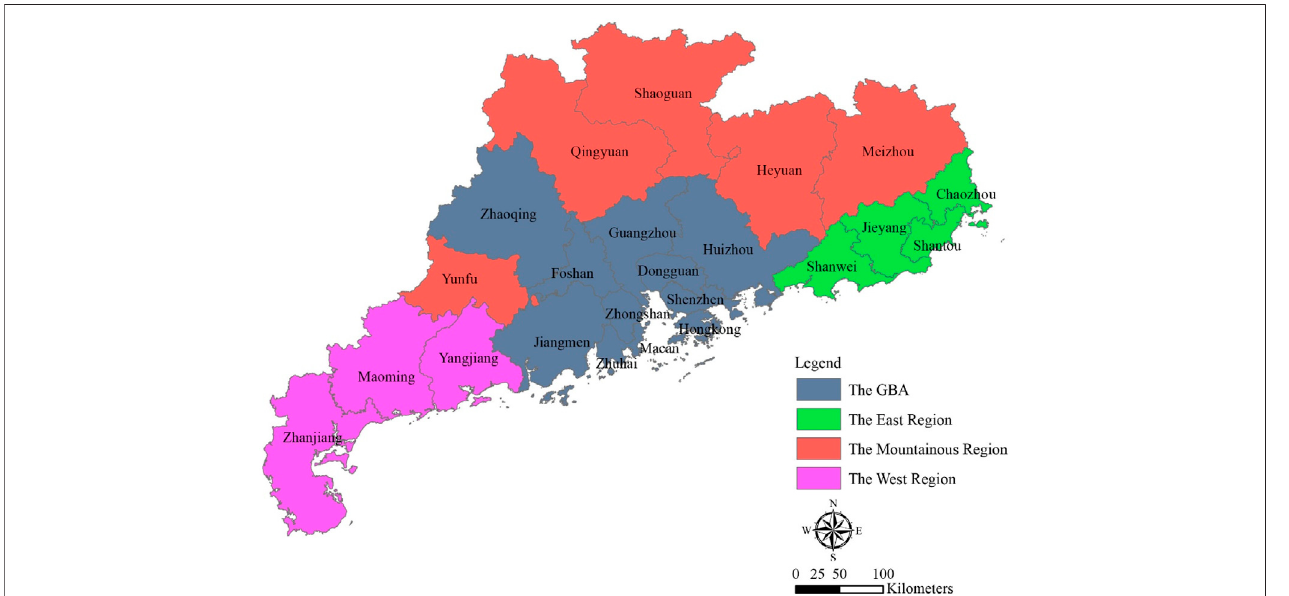
FIGURE 1 | Cities of and around the